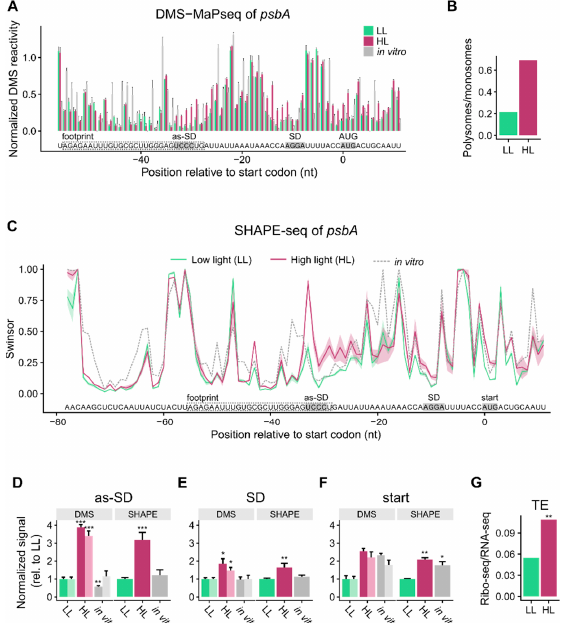
Figure 1. mRNA secondary structure changes in the translation initiation region of psbA : Increased accessibility of the Shine-Dalgarno sequence and the start codon correlates with increased translation efficiency. ( A ) DMS-based mapping of psbA mRNA secondary structure of young, 17–18-days-old plants as determined by MaPseq. Normalized DMS reactivities are given to account for the differences between adenosines/cytidines vs. guanosines/uridines reactivities (Supplemental Figures S3A and S4A). Furthermore, the values of a control without added DMS (Supplemental Figure S4A) were subtracted and outliers were removed by winsorization (only the 90th percentile is retained). The information obtained at adenosines/cytidines is more reliable than at guanosines/uridines (Supplemental Figures S3B and S5A) [27]. High normalized DMS reactivity indicates single-stranded nucleotides. The data for the low light (LL) control are shown in light green, the high light (HL) samples in dark red, and the mRNA that was allowed to fold in vitro in gray. The error bars indicate the mean standard error. The start codon (start), Shine-Dalgarno sequence (SD), and a sequence that can bind the SD (as-SD) are marked. The position of the footprint of a putative regulatory protein is given as a dashed box (Supplemental Figure S11A). A comparison of the DMS-probed RNA with a water-treated control is shown in Supplemental Figure S4A. ( B ) Polysome analysis of psbA translation in 17–18-days-old plants (Supplemental Figure S1). The ratio of the psbA mRNA amount in the five most dense fractions (polysomes) to the amount in the five least dense fractions (monosomes) is given. ( C ) SHAPE analysis (NAI-N 3 probing) of young leaves of seven-week-old plants. SHAPE signals indicate the extent to which each nucleotide is unpaired. Swinsor values are the termination counts, i.e., how often reverse transcription was stopped at each nucleotide by a bound NAI-N 3 probe, normalized by winsorization (only the 90th percentile is retained, outliers are discarded). High swinsor values indicate unpaired nucleotides, low swinsor values base-paired nucleotides. The shaded areas around the lines indicate the mean standard error. ( D ) Average of mRNA secondary structure at the sequence binding the Shine-Dalgarno sequence (as-SD), as revealed by DMS and SHAPE values normalized to the low light values. The DMS columns in darker color represent the more reliable reactivities at adenosines/cytidines, the lighter the reactivities at all four nucleotides. Asterisks here (and in ( E , F )) indicate statistically significant changes compared to LL ( p -values calculated with the Wilcoxon rank sum test; * = p < 0.05, ** = p < 0.01, and *** = p < 0.001), error bars indicate mean standard error. ( E ) Average structure at the Shine-Dalgarno sequence (SD). ( F ) Average structure at the start codon (start). ( G ) Change in translation efficiency (ratio footprints/transcript levels) of psbA mRNA in young leaves of seven-week-old plants (Figure 4, Figures S12 and S13). Asterisks indicate statistically significant changes (calculated with RiboDiff; ** = p <